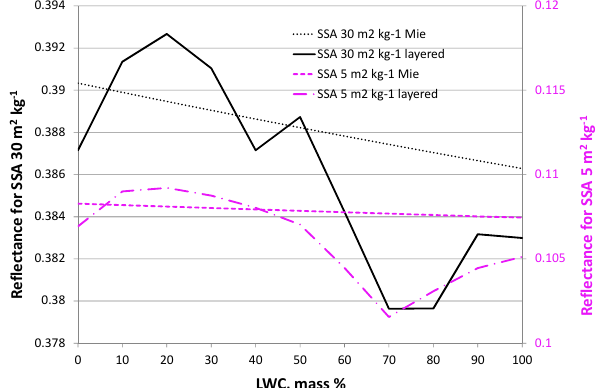
Figure 3. Effect of the LWC on the reflectance of snow for SSAs of 5 and 30m 2 kg − 1 , density of 300kgm − 3 and an optically semi- infinite layer at 1310nm. Each SSA has its own vertical axis.